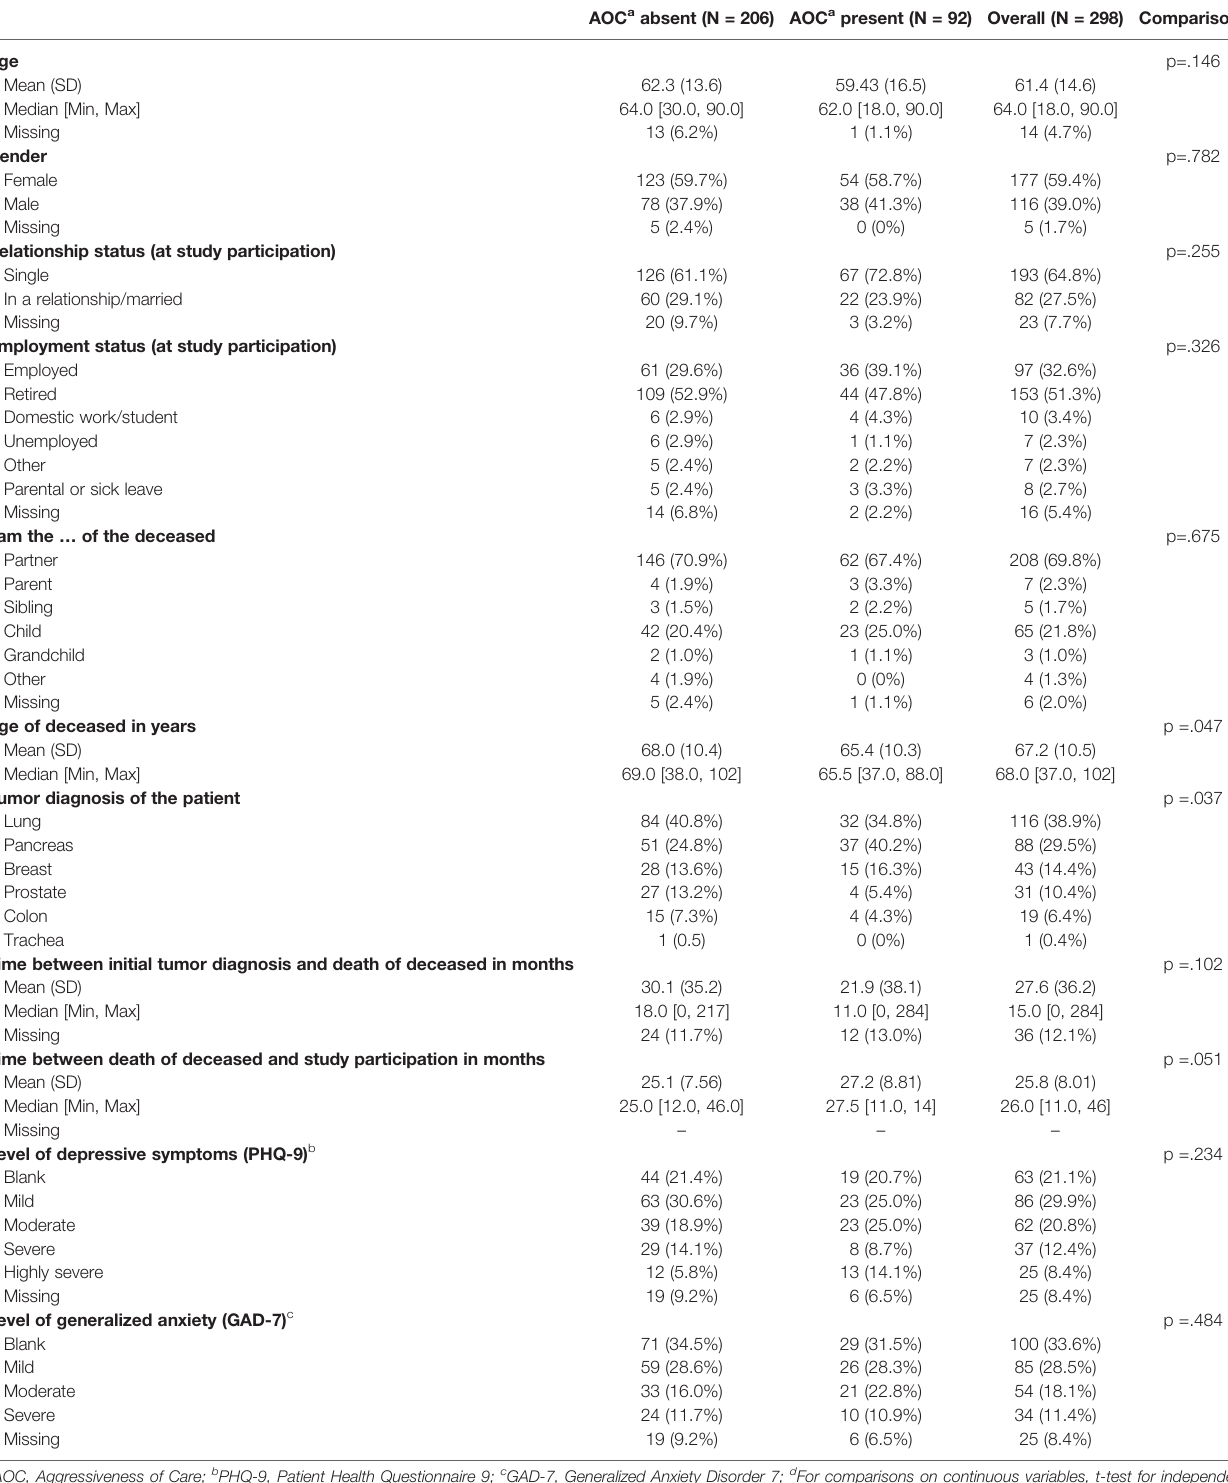
TABLE 1 | Characteristics of